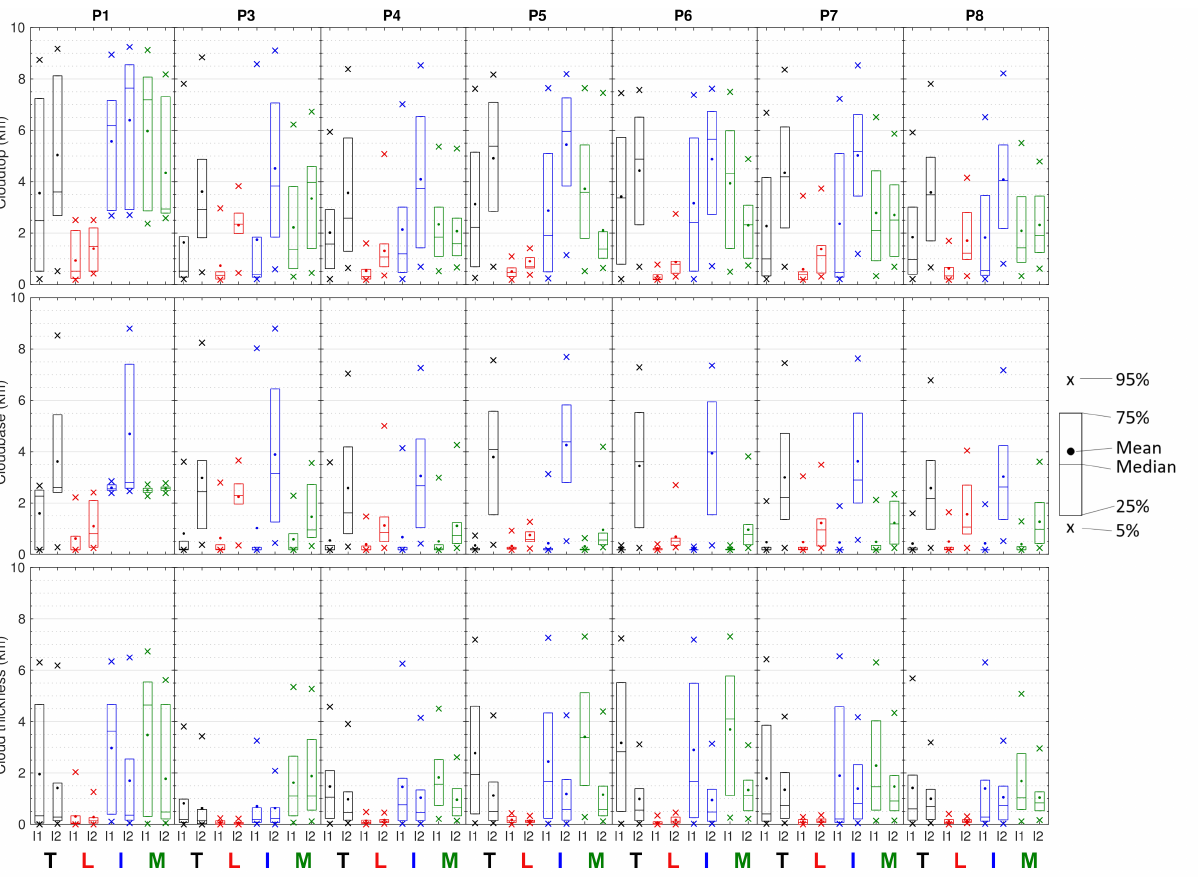
Figure 17. Statistical overview of cloud top height (top row), cloud base height (middle row), and geometrical thickness (bottom row) for the eight key periods of AO2018. The colours indicate the different cloud types, total (T), liquid (L), ice (I), and mixed-phase (M) clouds. Results for the lowest two cloud layers (l1 and l2) are shown.